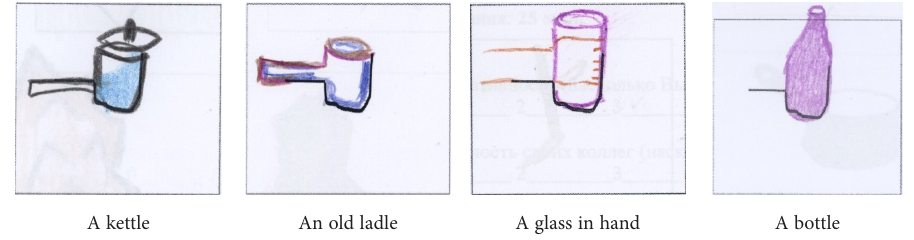
Figure 6. The creative task: interpretation of Fragment 1 – kitchenware and dishes (source: testingmom.com, 2020) Three research participants provided exceptional associated images and five exceptional images were presented while interpreting the fragment. The students from Lithuania inter- preted Fragment 1 as “a candy” and “a curve”, the students from Latvia drew a punctuation mark (“a question mark”, and the participants from Belarus – a character – “a witch” and a violent scene – “a murder” (Figure 7).